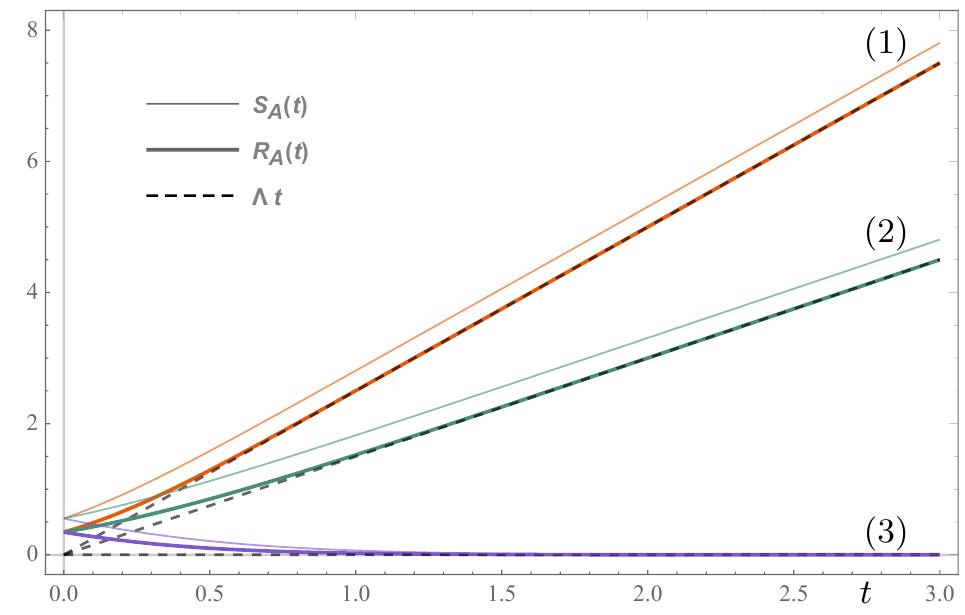
Figure 2 . Particle in a 2d inverted potential . The plot shows the exact behavior of the R(cid:19)enyi en- tropy R A ( t ) (thick) and entanglement entropy S A ( t ) (thin) in comparison to the predicted asymp- totics (cid:3) t (dashed). The system is de(cid:12)ned in (3.1) with subsystems speci(cid:12)ed in (3.4){(3.6). For the computation, we choose (cid:21) 1 = (cid:0) (cid:21) 4 = 2 and (cid:21) 2 = (cid:0) (cid:21) 3 = 1 = 2. The initial state is chosen to be j J 0 i with associated metric G 0 ( ‘ i ; ‘ j ) = (cid:14) ij . In the case of examples (1) and (2), we have S A ( t ) (cid:0) R A ( t ) ! c = 0 : 31, while for example (3), we have S A ( t ) ! R A ( t ) ! 0 for large t